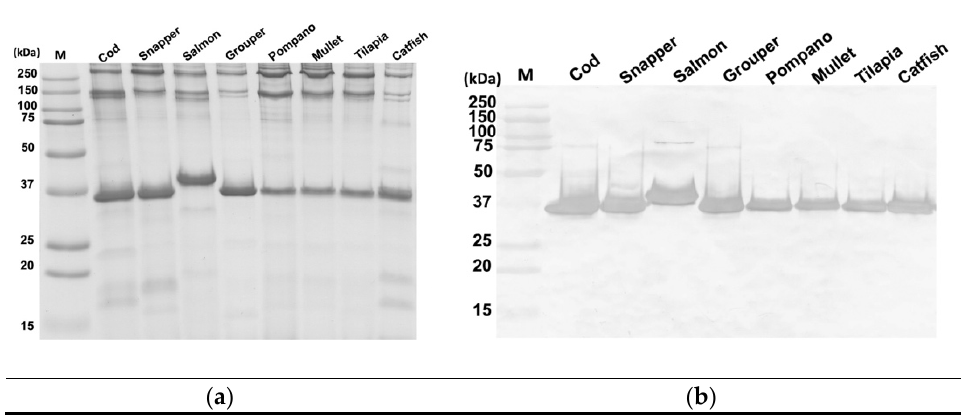
Figure 1. SDS-PAGE ( a ) and western blot analysis ( b ) of cooked fish samples using mAb 8F5 su- pernatant (1:5). The amount of sample loaded on the 12% SDS-PAGE was 6 μ L per lane. M: molec- supernatant (1:5). The amount of sample loaded on the 12% SDS-PAGE was 6 µ L per lane. M: ular weight marker. molecular weight